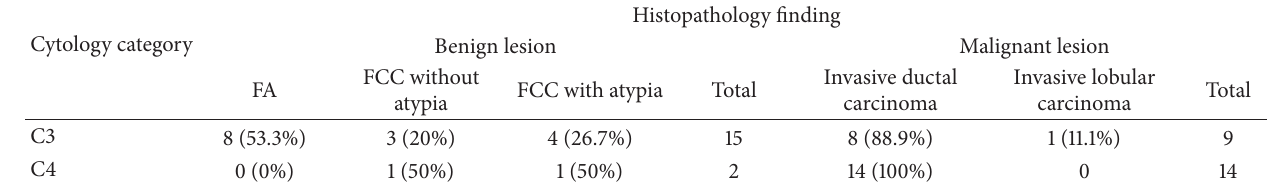
Table 2: Histopathology of breast masses according to the cytological diagnosis. Cytology